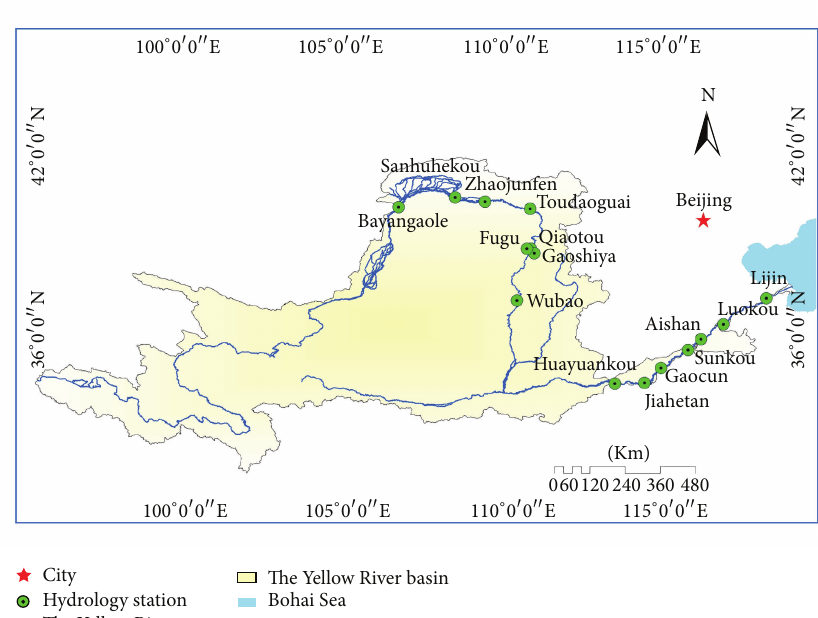
Figure 1: Schematic of the Yellow River